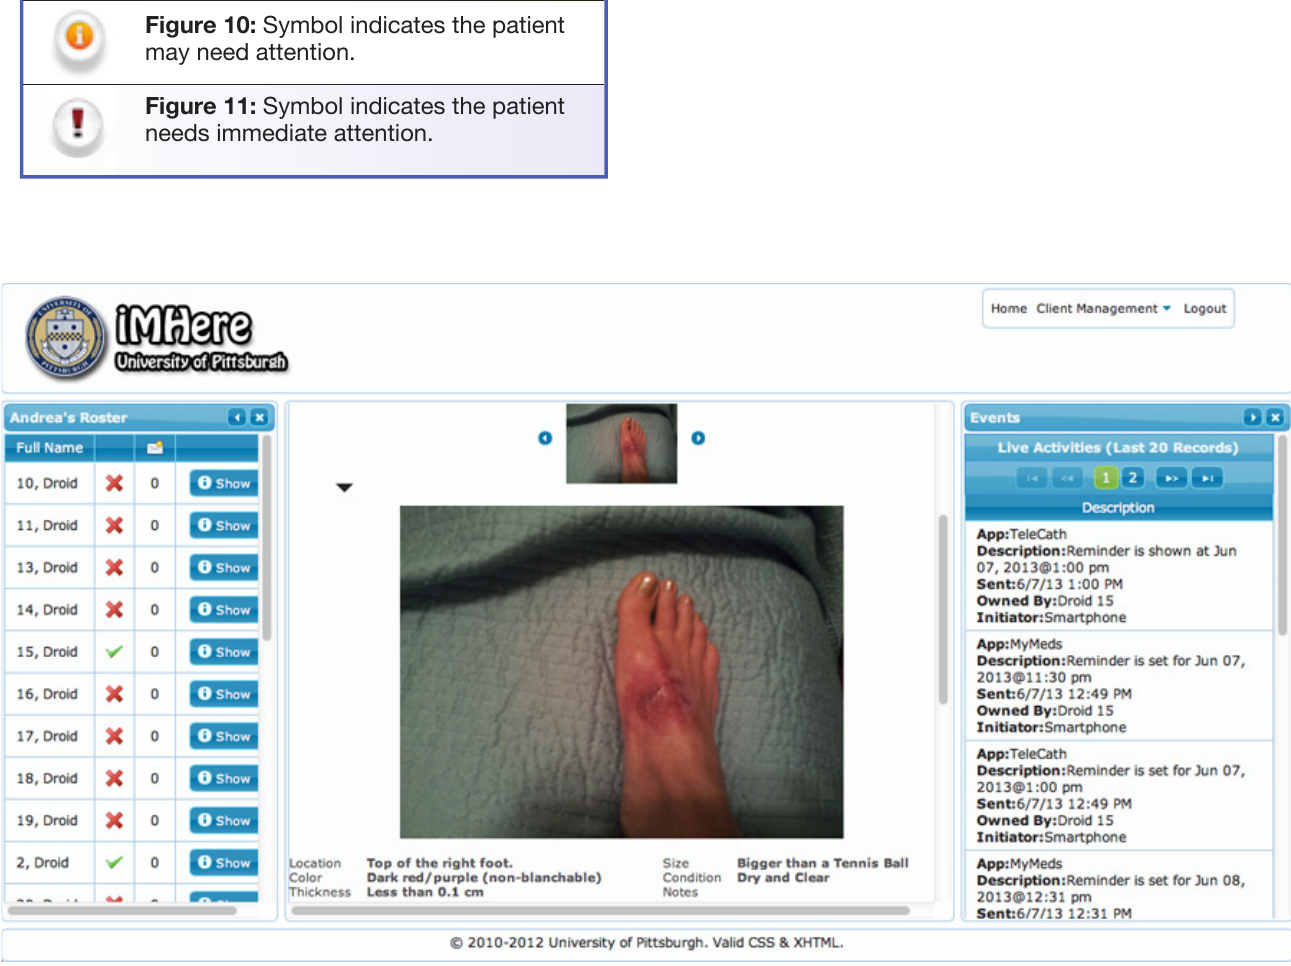
Additional description regarding the technical aspects